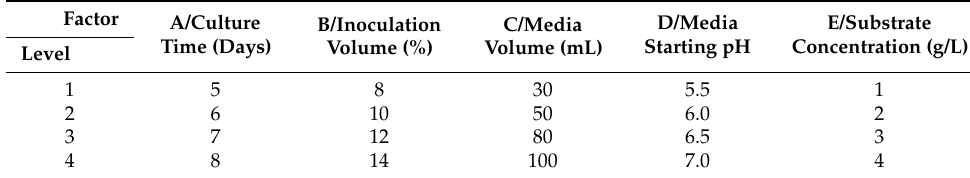
Table 1. Orthogonal experimental factors and level assignments.